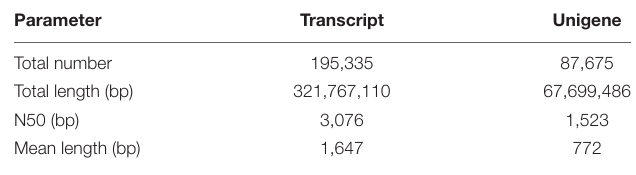
TABLE 2 | Summary of sequence